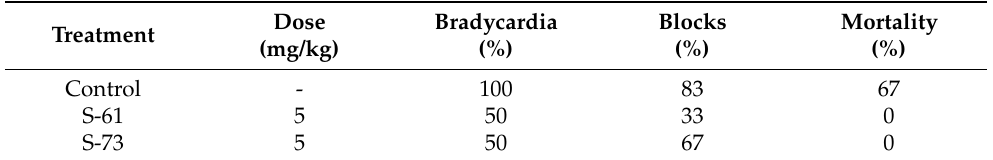
Table 3. The therapeutic antiarrhythmic activity of pyrrolidin-2-one derivatives in adrenaline-induced arrhythmia model.